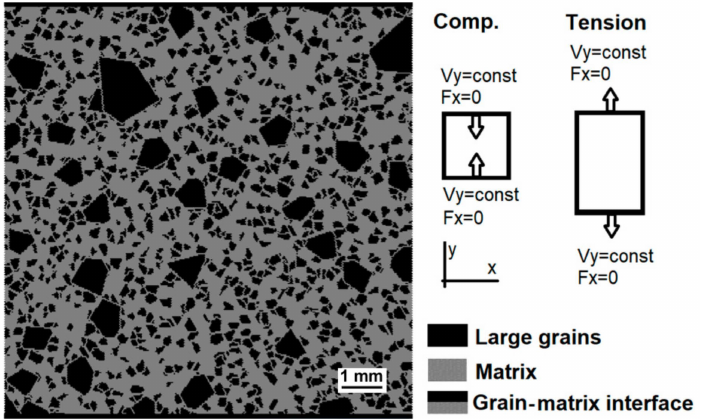
Figure 2. Schematic of DEM models of uniaxial compression and tension. The picture shows the model sample 1 × 1 cm 2